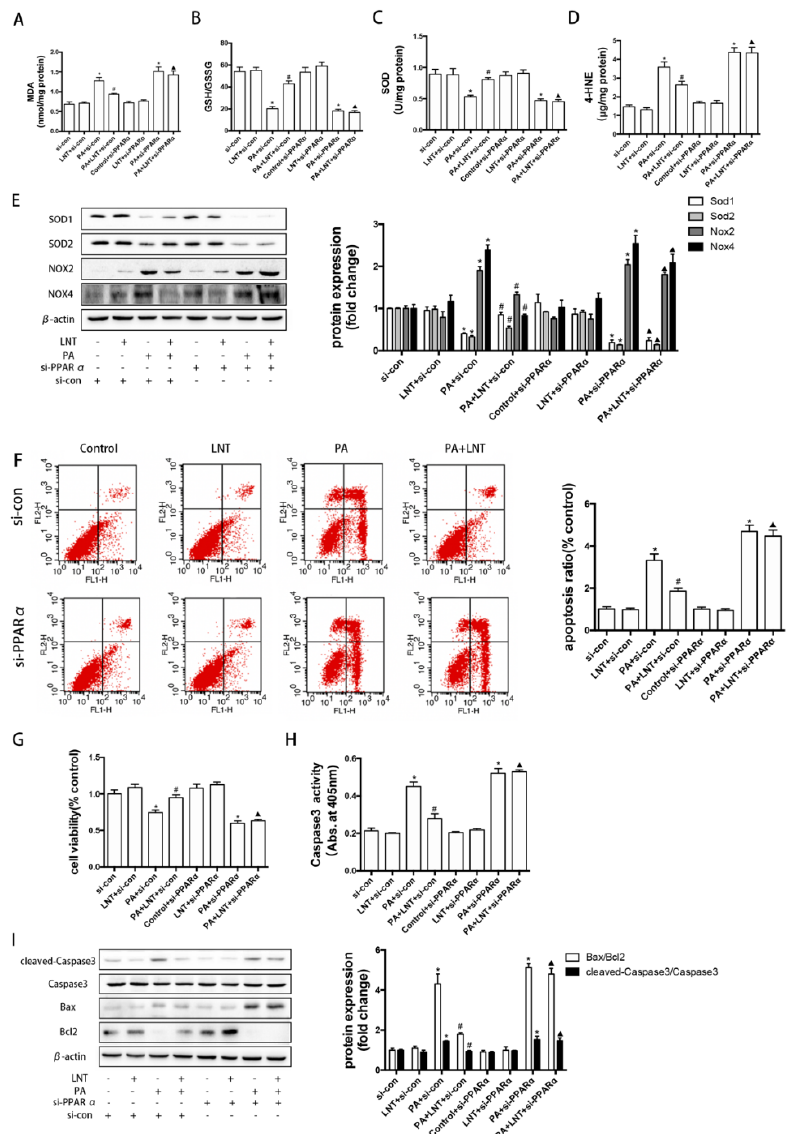
Figure 6. PPAR α knockdown abolished the effects of LNT on oxidative stress and apoptosis in PA-induced AML12 cells. ( A – D ) MDA, GSH/GSSH, SOD, and 4-HNE levels in AML-12 cells. ( E ) Representative Western blots and quantification of SOD1, SOD2, NOX2, and NOX4 in AML-12 cells. ( F ) Representative annexin-V-FITC/PI staining and quantification of apoptosis by flow cytometry. ( G ) Cell viability and ( H ) Caspase3 activity in AML-12 cells. ( I ) Representative Western blots and quantification for cleaved Caspase3, apoptosis-related proteins in AML-12 cells. Data are presented as the mean ± SEM ( n = 3 per group). * p <0.05 compared with the si-con group. # p < 0.05 (cid:78) p compared with the PA+si-con group. < 0.05 compared with the PA+LNT + si-con